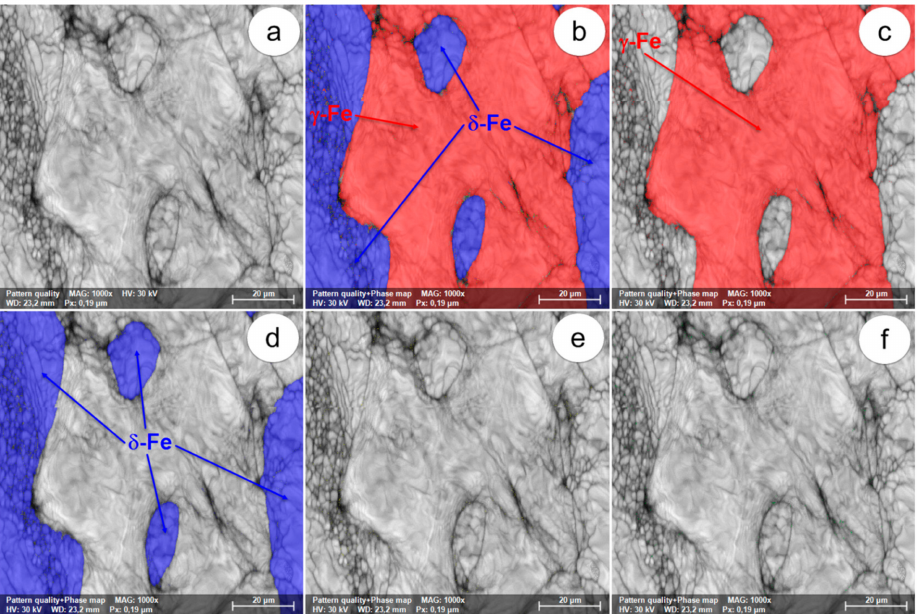
Figure 15. The SEM-EBSD composite images ( × 1000) obtained after forging at 1050 ◦ C: ( a ) microstructure of the analysed field; ( b ) the distribution of existing phases in the microstructure of the analysed field; ( c ) the distribution of the γ -Fe phase; ( d ) the distribution of the δ -Fe phase; ( e ) the distribution of the σ -(Fe-Cr) phase; ( f ) the distribution of the χ -(Fe-Cr-Mo)